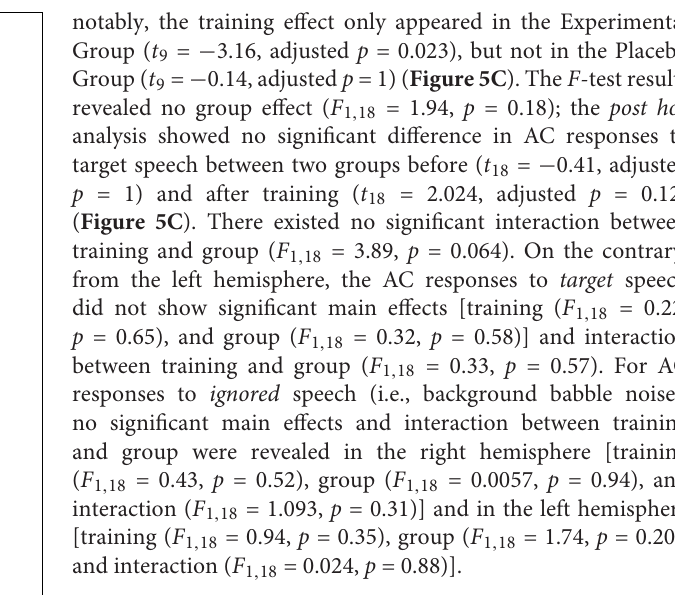
exhibited a Bonferroni-corrected p -value of 0.022 (i.e., six times uncorrected p -value 0.0036) in the Experimental